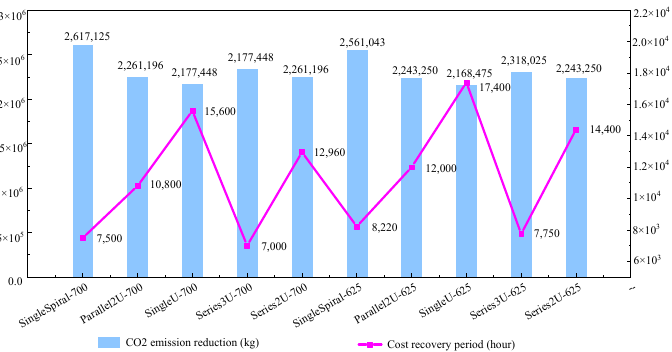
Figure 10. Querying results of CO 2 emission reduction and cost recovery period.